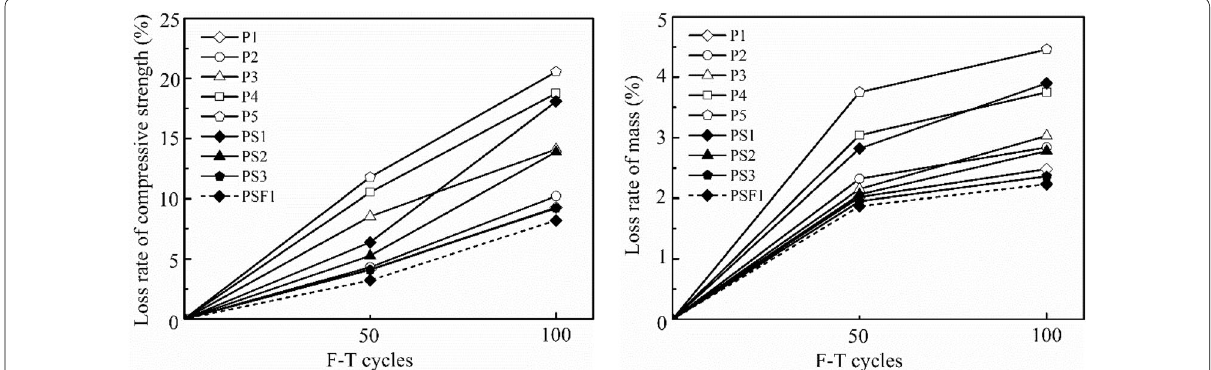
Fig. 9 The results of the freeze–thaw durability tests of pervious concrete